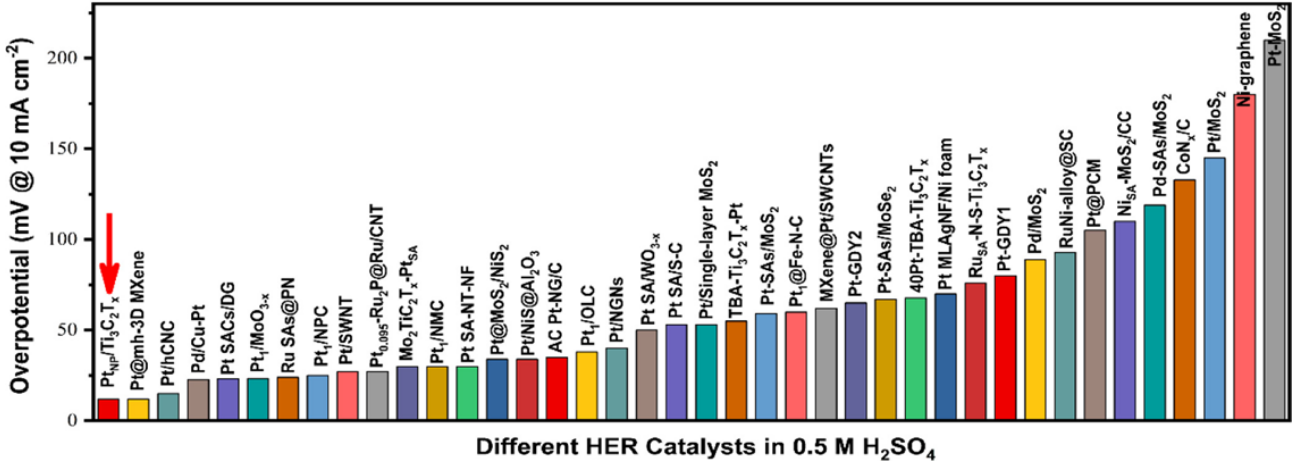
Figure 9. Overpotential comparison of Pt NP /Ti 3 C 2 T x with that of the previously reported Pt-based HER electrocatalyst in an acidic electrolyte. Adapted with permission [69]. Copyright 2022, American Chemical Society.